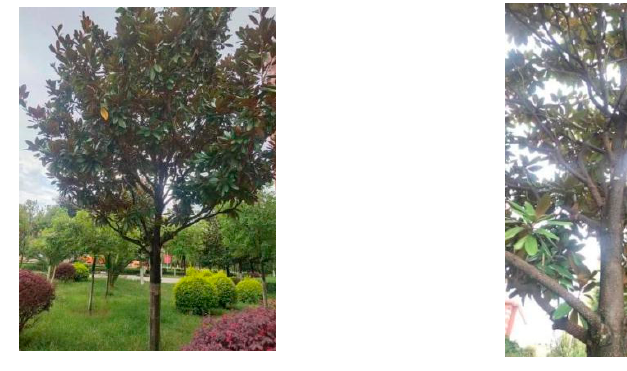
Figure 1. Schematic diagram of Magnolia samples.